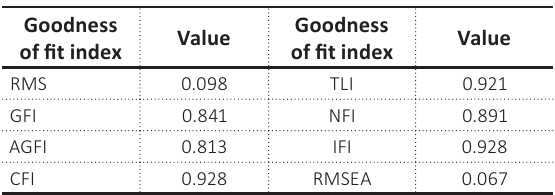
Table 3. Goodness-of-fit index of the BPTD scale